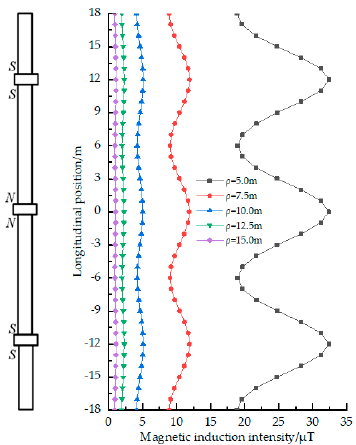
Figure 7. Variations of magnetic induction intensity along the pre-magnetized casing string under the homogeneous pole connection condition.